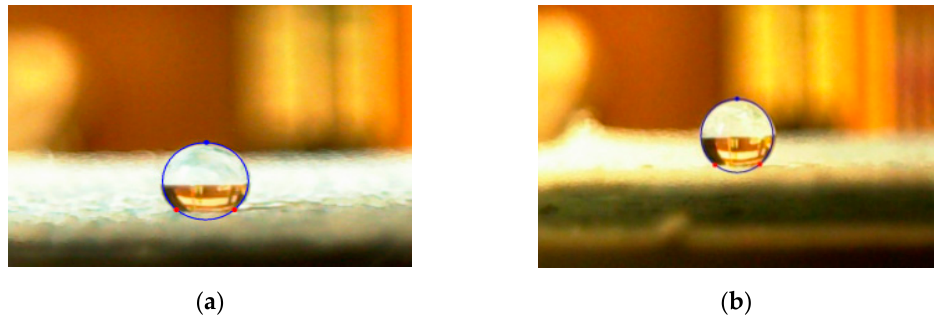
Figure 9. Images of the contact angle measurement: ( a ) 135.3°; ( b ) 142.3°.